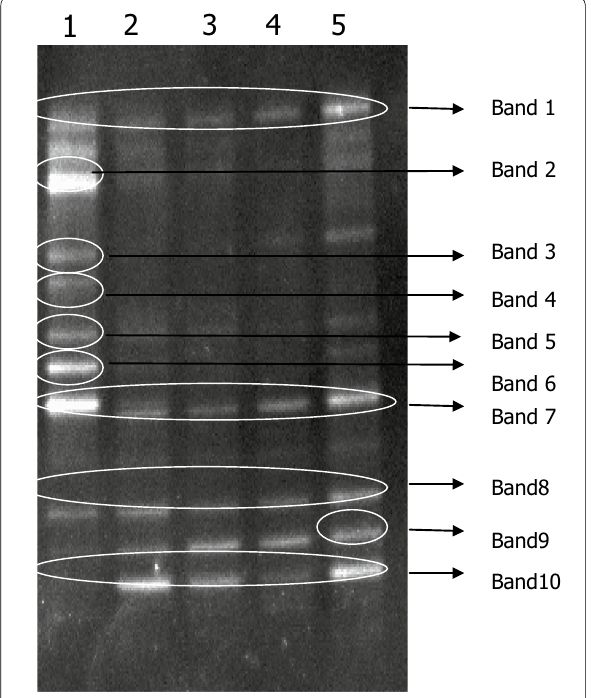
Fig. 1 DGGE analysis of microbial community structure change under the selective pressure of viscose fiber wastewater ( Lanes 1 1st day of subculture; 2 10th day of subculture; 3 20th day of subculture; 4 30th day of subculture; 5 40th day of